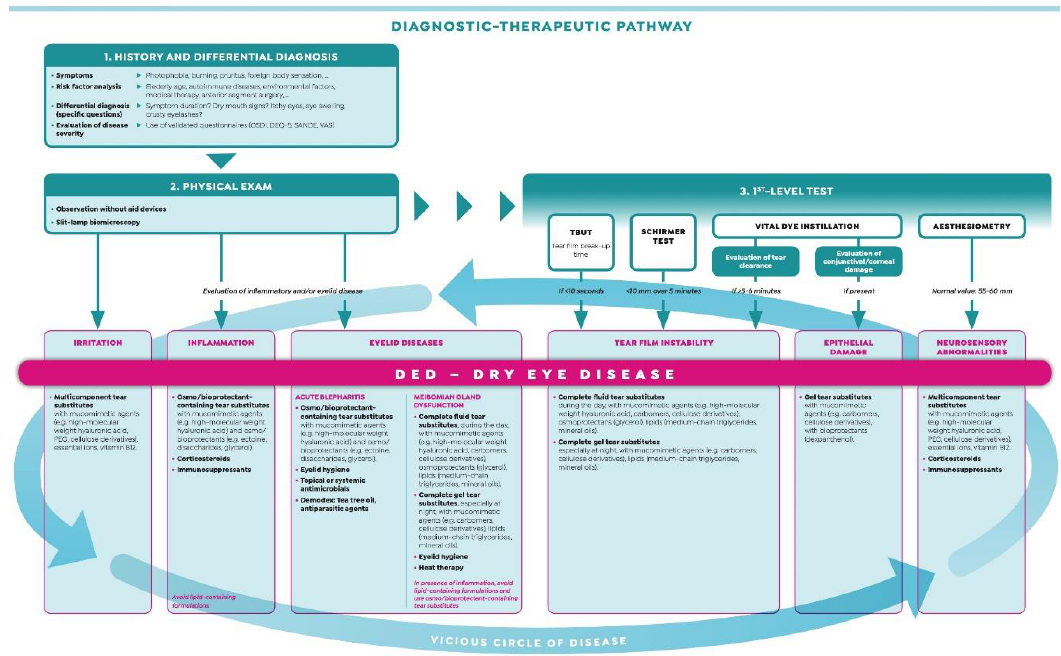
Figure 1. Diagnostic–therapeutic pathway of dry eye disease. Modified from “Malattia dell’Occhio Secco—Dalla definizione alle strategie terapeutiche” with the permission of Editamed srl. Medical Fact #5: “The Diagnosis of Dry Eye (Detection & Assessment) Is Possible in 10 min in a Low-Tech Office”